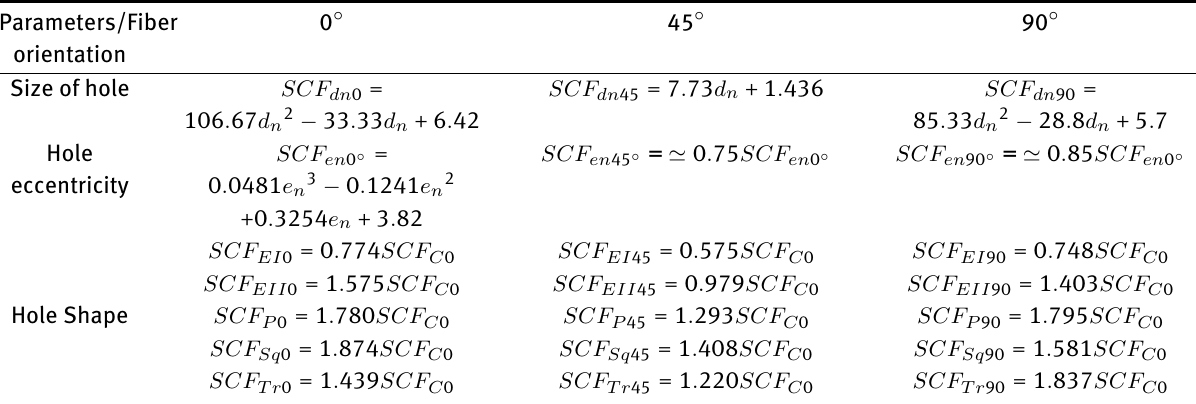
Table 8: Simplified formulas for SCF evaluation